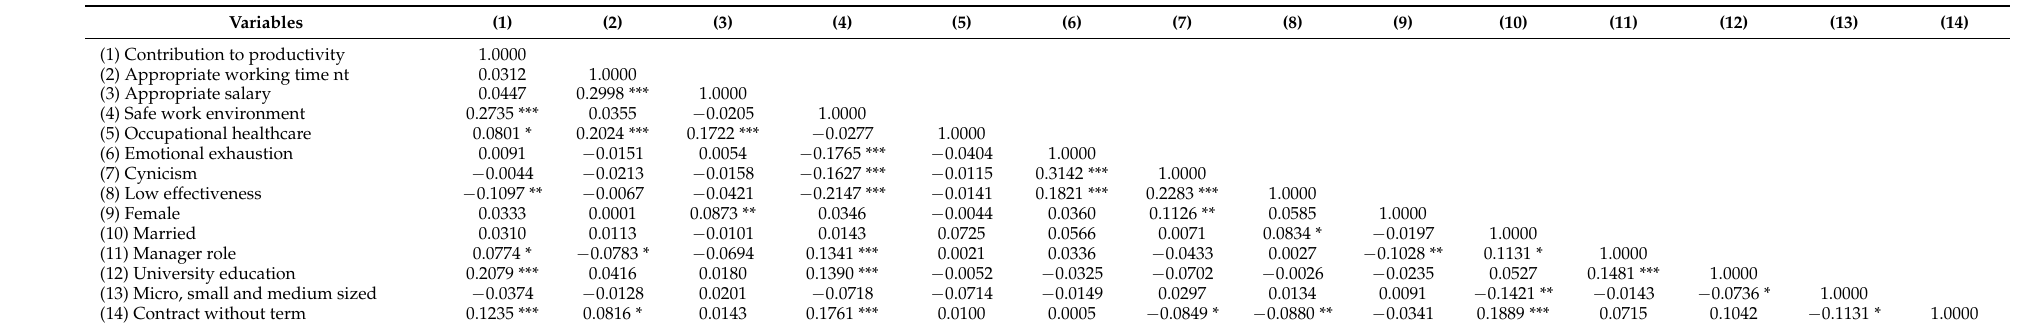
Table 3. Correlation coefficient